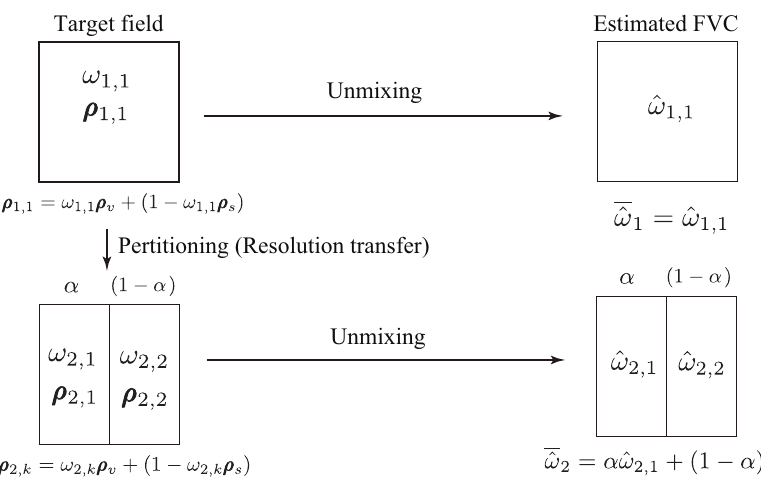
Figure 4. Illustration of the variables, the partitioning process, and the unmixing process used to implement a FVC estimate using the isoline-based